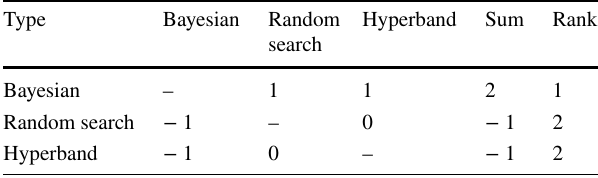
Table 4 Results from Mann–Whitney test